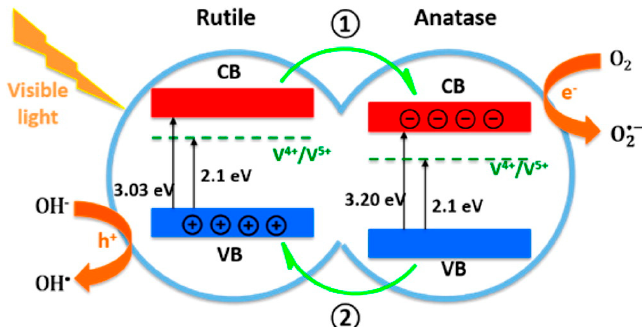
Figure 11. Schematic illustration of the synergistic mechanism of rutile and anatase. Reprinted with permission from [87]. Copyright 2018, American Chemical Society.